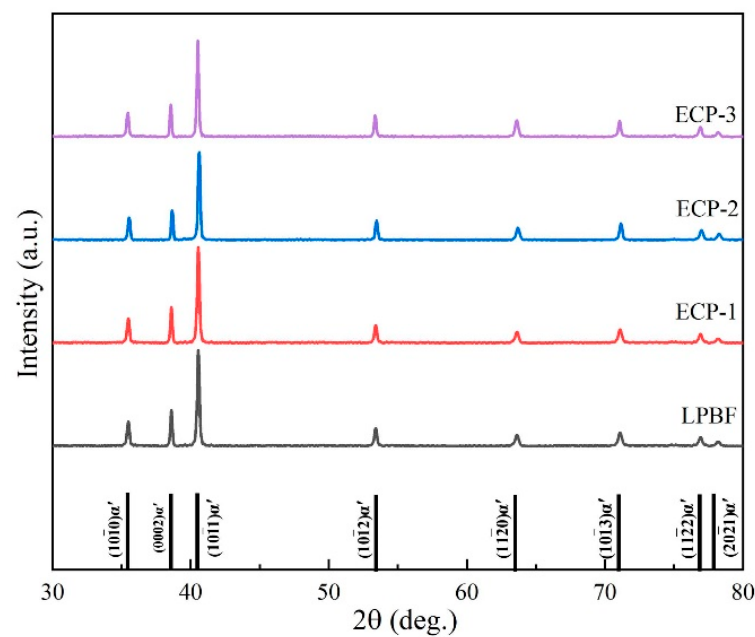
Figure 2. The XRD patterns of the LPBF-Ti64 samples before and after ECP treatment, the ideal peak positions of the α′ phase were indicated with the black lines at the bottom of the figure. Table 3. Lattice constants of α′ phase in the samples before and after ECP treatment.